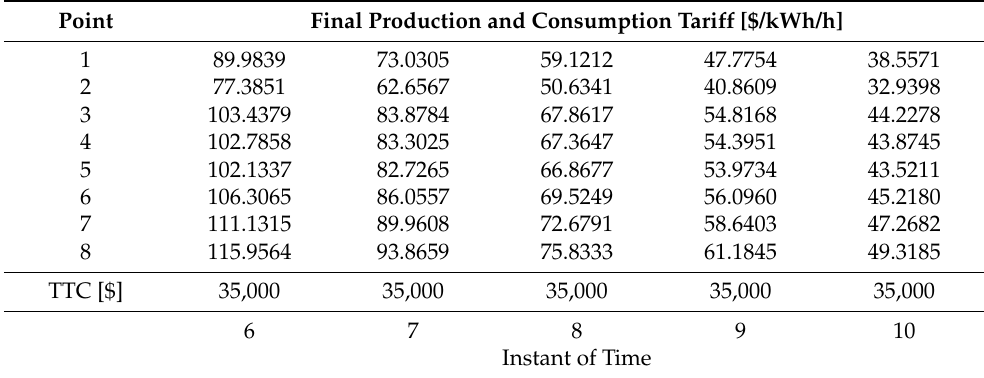
Table 9. Final production and consumption tariffs for each point and the total transportation cost between the instants of time 6 and 10 with W F = 0.25 and W B =